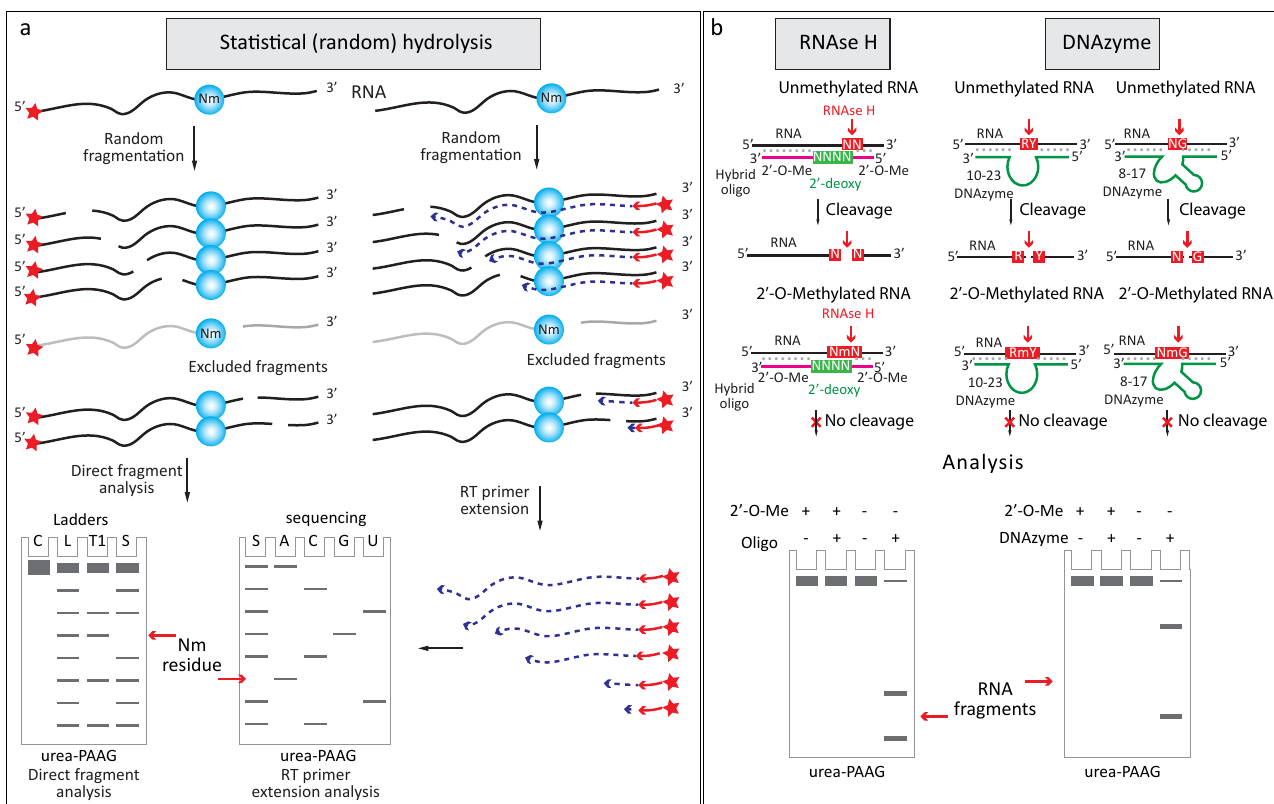
Figure 2. Analysis of 2 (cid:48) - O -methylation using resistance to nucleolytic cleavage ( a ) Random partial RNA hydrolysis generates “gaps” in the RNA ladder, an analysis can be done by direct RNA labeling (left) or by primer extension using a labeled DNA primer (right). To locate the exact position in the sequence, ladder with fragmented unmodified RNA (L) and RNase T1 cleavage (T1) was used in the case of directly labeled RNA (left). For primer extension, RNA sequencing with the same primer was used (right); ( b ) Guided cleavage by RNase H or DNAzyme is compromised when the nucleotide in RNA is 2 (cid:48) - O -methylated. Cleavage by RNase H is directed by hybrid synthetic oligonucleotide composed of 2 (cid:48) - O -Me residues and internal ‘window’ of four standard DNA nucleotides (indicated in green). Depending on the source of RNase H and the exact experimental conditions, the exact cleavage position in the duplex may vary [40]; the most common site is shown on Figure 2. DNAzymes 10–23 and 8–17 are standard DNA oligonucleotides, 10–23 version cleaves Purine-Pyrimidine (RY) sequence context, 8–17 variant acts at any nucleotide-G (NG) contexts. Nm: 2’- O -methylated